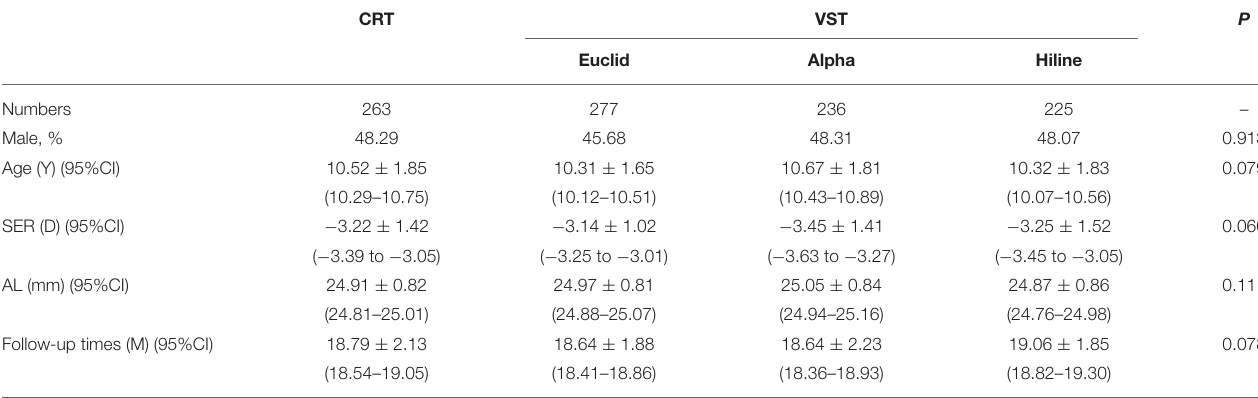
TABLE 2 | Baseline demographics for the four groups.